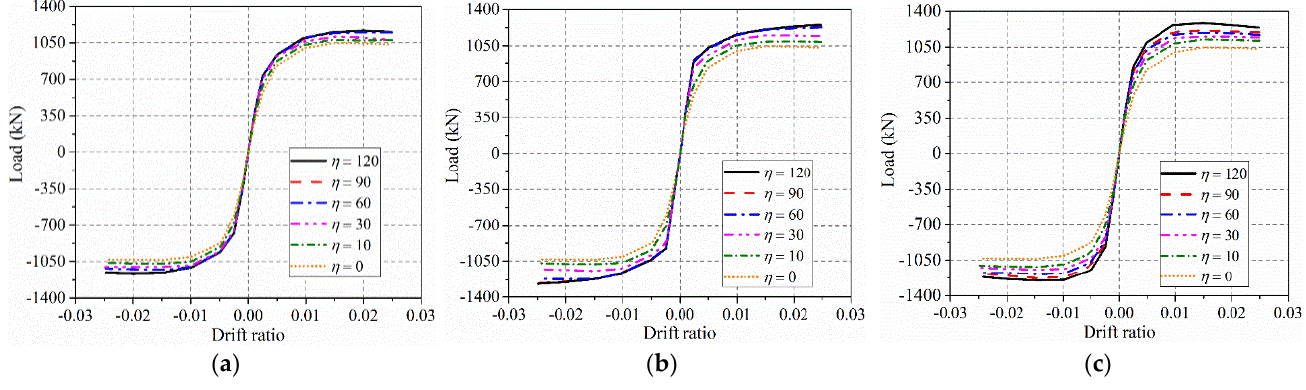
Figure 11. Envelope curves for: ( a ) SPSW1 − 1VHS, ( b ) SPSW1 − 3VHS, and ( c ) SPSW1 − DS with variable η .